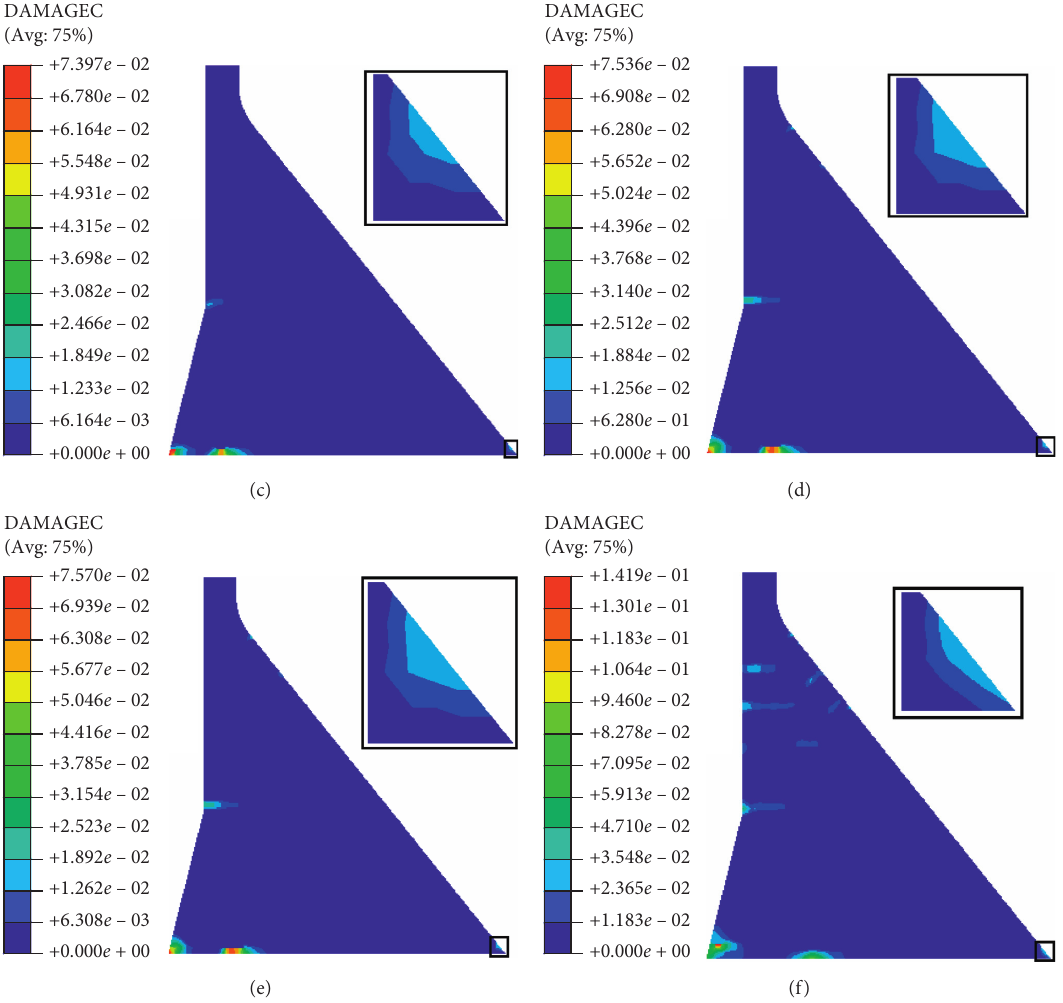
Figure 16: The compression damage-rupture process considering both the tension and compression damage. (a) 1.0. (b) 1.2. (c) 1.4. (d)